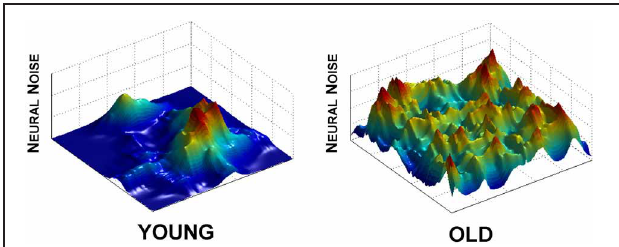
FIGURE 3 | Effect of aging on neural noise modulation. As the solution manifold decreases in size, so does the ability to clearly delineate noise levels across the many regions of the brain. What results is a more even distribution of neural noise levels in the aging brain (old, right panel) in comparison to the clear peaks and valleys of the young (left panel). Effectively, this represents dedifferentiation across brain regions, but, reflected in neural noise levels. We used powernoise.m (Little et al., 2007) to generate the randomized patterns for these